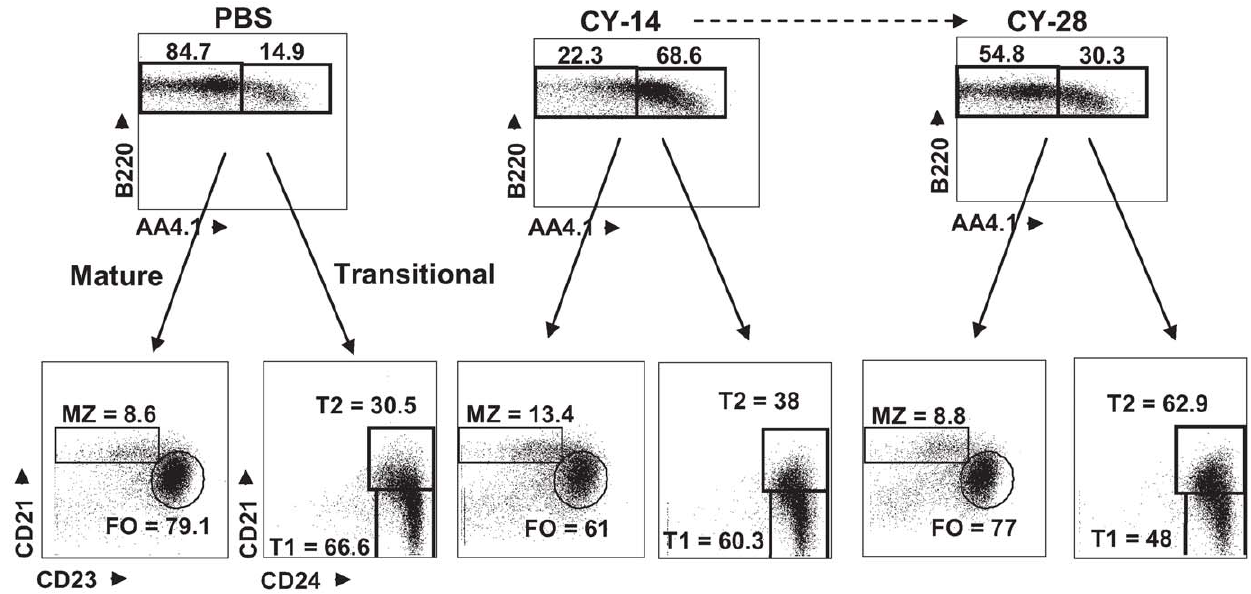
Figure 2. Splenic B cell populations following CY or PBS treatment. The markers B220 and AA4.1 were used to differentiate mature (B220 + / AA4.1 2 ) and transitional (B220 + /AA4.1 + ) B cell subsets. The mature B cell gate was used to identify marginal zone (CD21 hi /CD23 2 ) and follicular (CD21 hi/ CD23 pos ) populations and the transitional gate was used to identify T1 (CD21 neg /HSA hi ) and T2 (CD21 pos /HSA hi ) subsets. Five mice were analyzed at each time point. Representative data are shown. The absolute numbers are presented in Table 2.